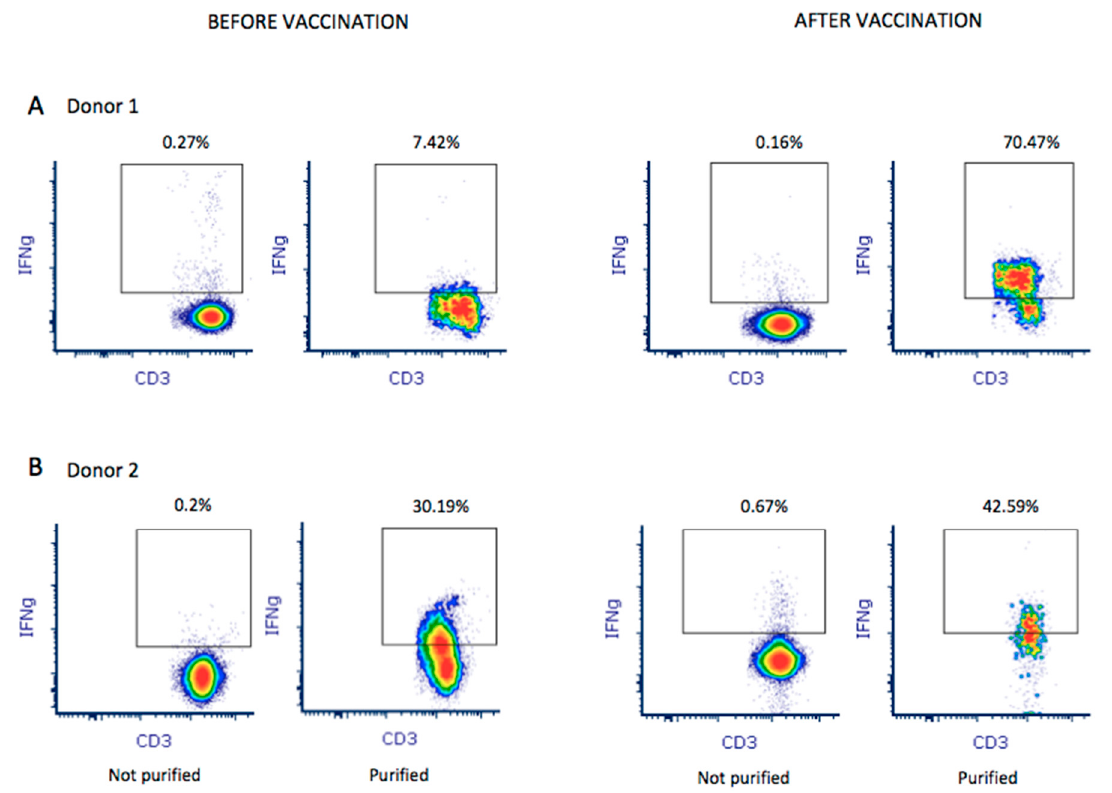
Figure 2. A total of 1 × 10 9 leukocytes were used to purify and enrich M-protein SARS-CoV-2-specific T-cells from both donors before and after vaccination. Enrichment of IFN γ + CD3+ T-cells in the final product was analyzed by flow cytometry for donor 1 ( A ) and donor 2 ( B ). Percentage of enrichment was quantified by establishing the quality control before purification as baseline (not purified).